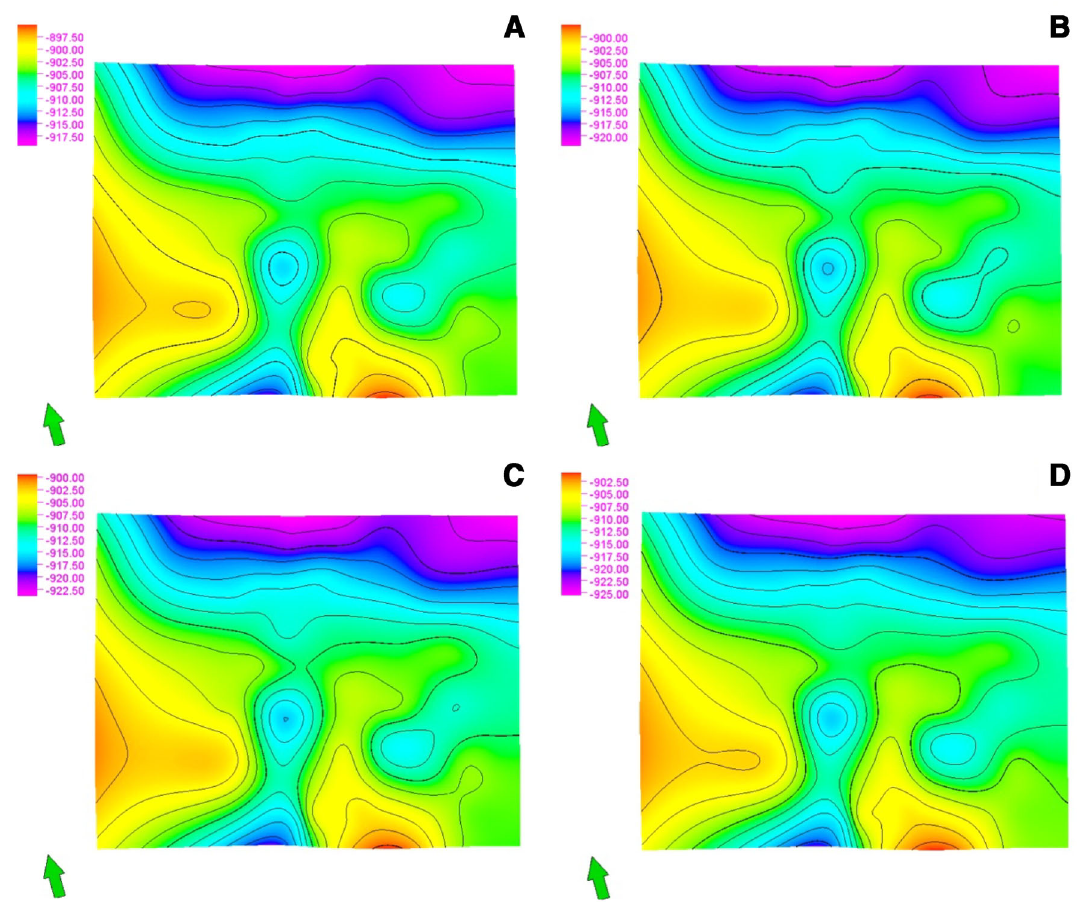
Fig. 3 The stratigraphic models of the study area. a The stratigraphic model of the S215 layer. b The stratigraphic model of the S215-1 layer. c The stratigraphic model of the S215-2 layer. d The stratigraphic model of the S216 layer